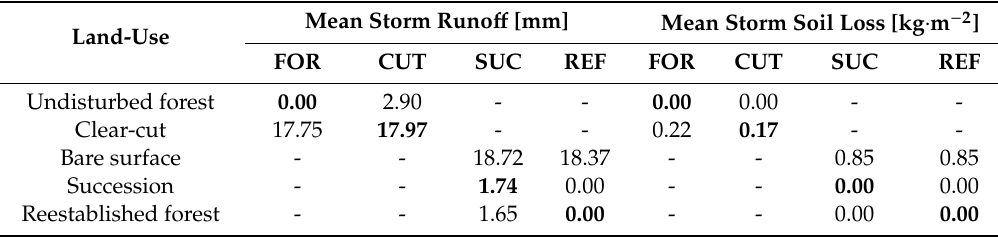
Figure 16. Modeling results (annual and storm) for (SUC)cession and (REF)orested sites, using realistic slope geometry and different land managements. Table 18. Mean modeled storm runo ff and soil loss. Bold values represent current land use.